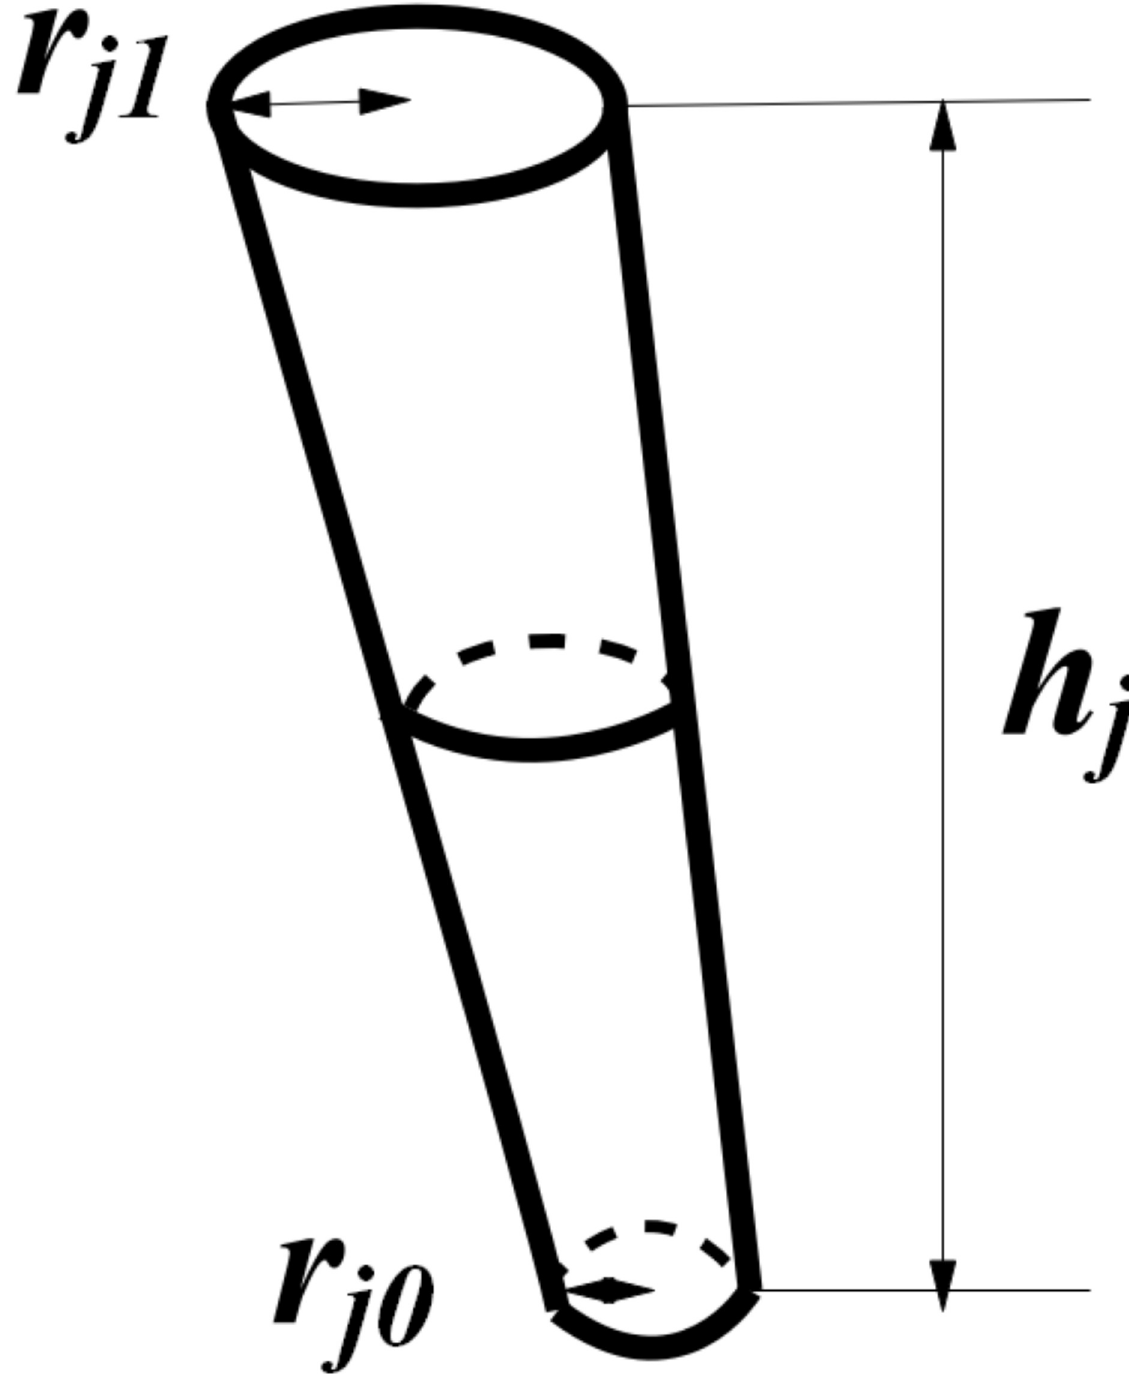
Fig 4. Schematic diagram of the main stem